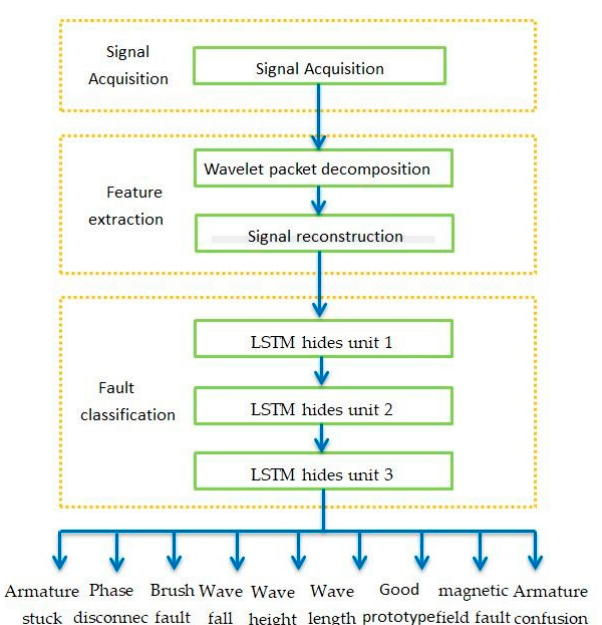
Figure 16. Algorithm flow chart.